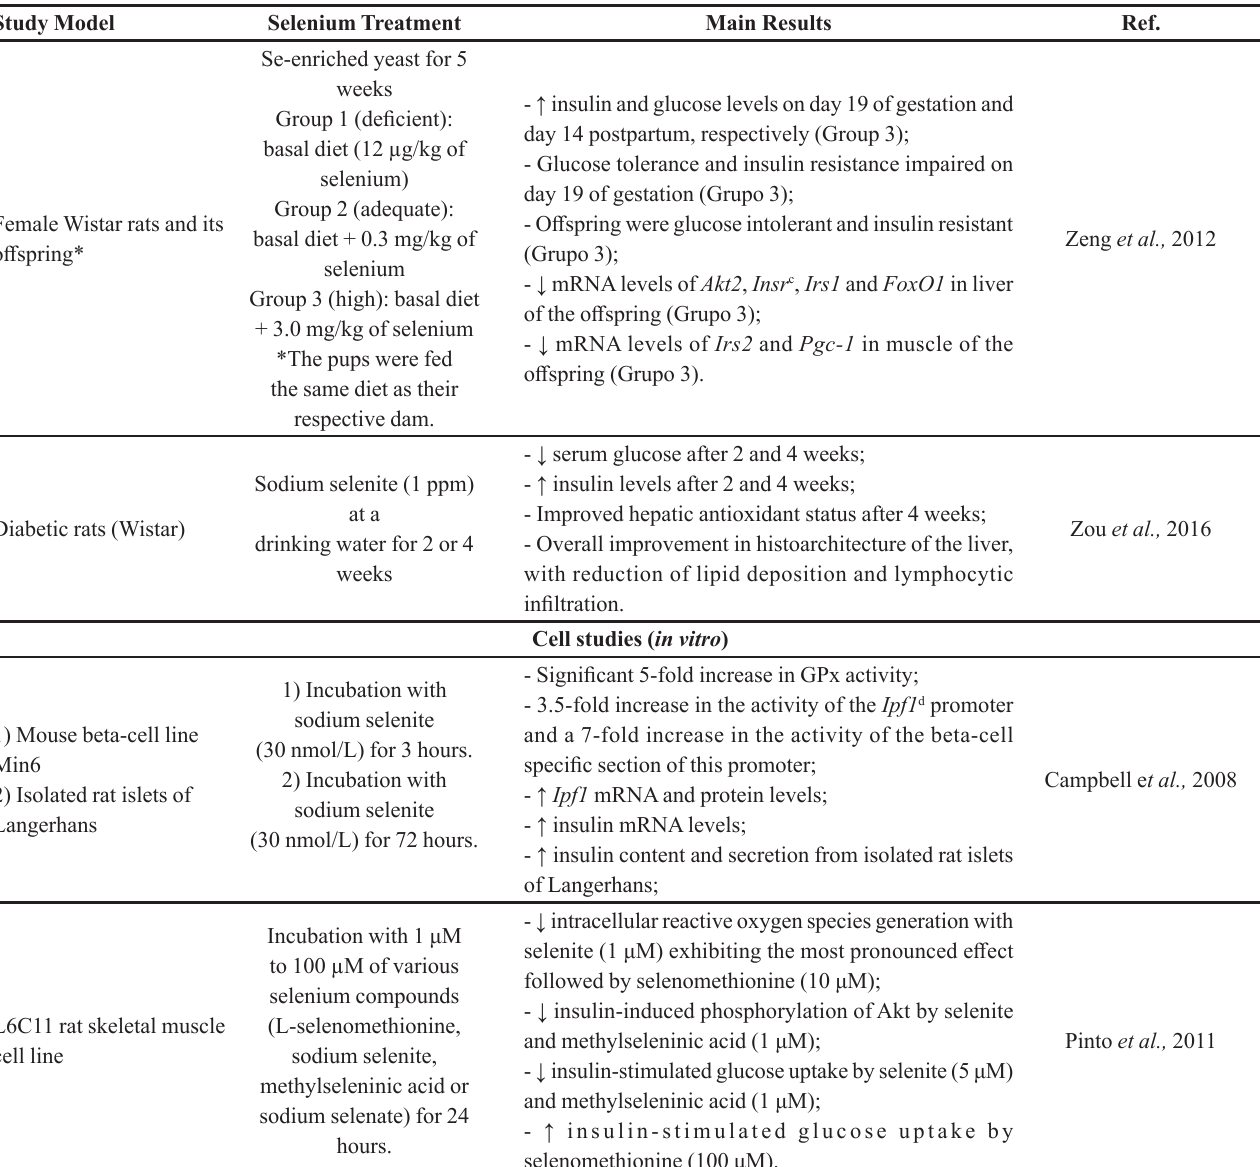
TABLE II - Selenium, glycemic parameters and insulin resistance: a summary of studies in cellular and non-human animal models